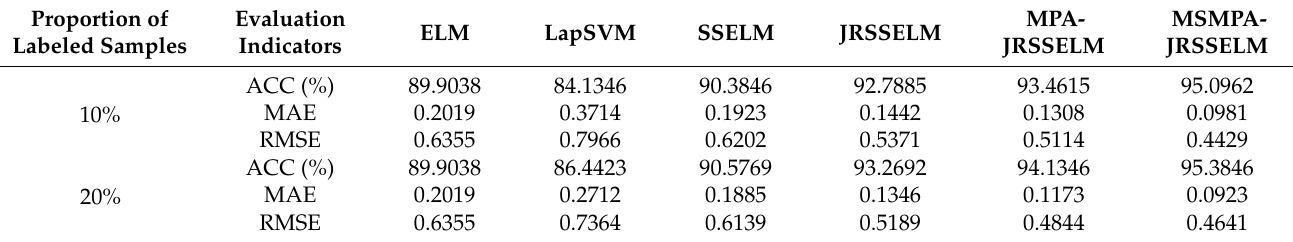
Table 7. Performance of each model on well 1.